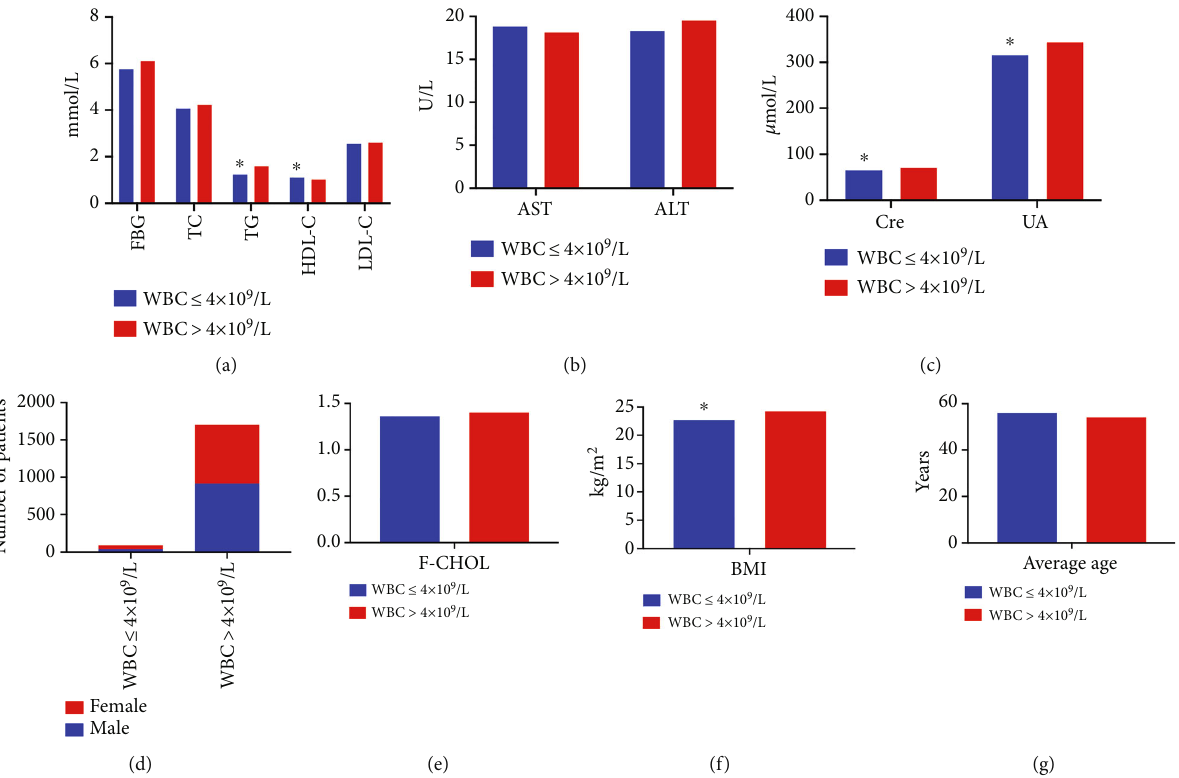
Figure 1: Comparison of di ff erent indicators between the WBC ≤ 4 × 10 9 /L and WBC > 4 × 10 9 /L groups. (a) Comparison of levels of FBG, TC, TG, HDL-C, and LDL-C between the two groups. The levels of TG and HDL-C in the WBC ≤ 4 × 10 9 /L group were signi fi cantly lower than that in WBC > 4 × 10 9 /L group. (b) Comparison of AST and ALT levels between the groups. (c) The levels of Cre and UA in the WBC ≤ 4 × 10 9 /L group were signi fi cantly lower than that in the WBC > 4 × 10 9 /L group. (d) Comparison of the number of male and female patients between the groups. (e) Comparison of levels of F-CHOL between the groups. (f) The BMI of patients in the WBC ≤ 4 × 10 9 /L group was signi fi cantly lower than that in the WBC > 4 × 10 9 /L group. (g) Comparison of the average age of patients between the two